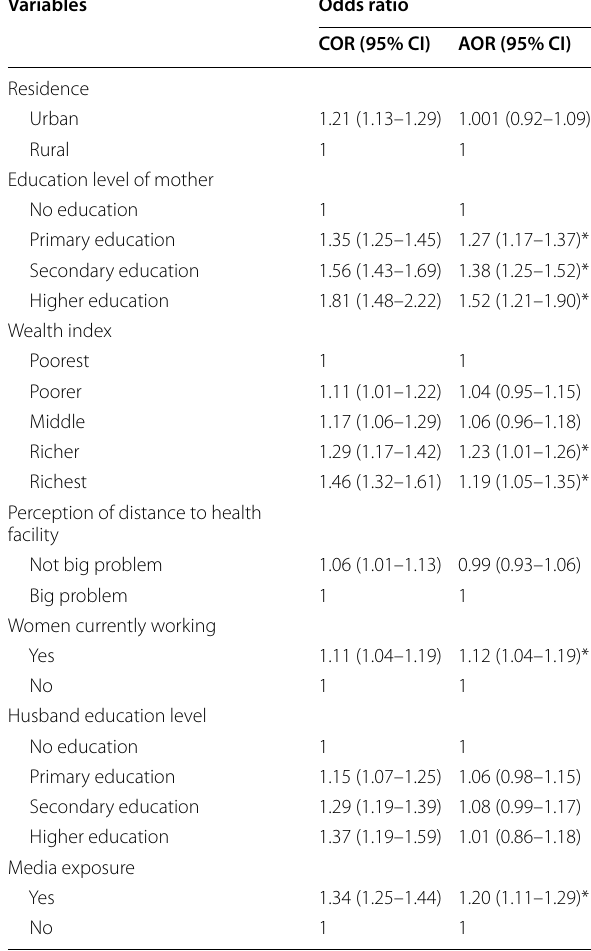
Table 3 Multilevel logistic regression analyses for the factors associated with appropriate feeding practice in